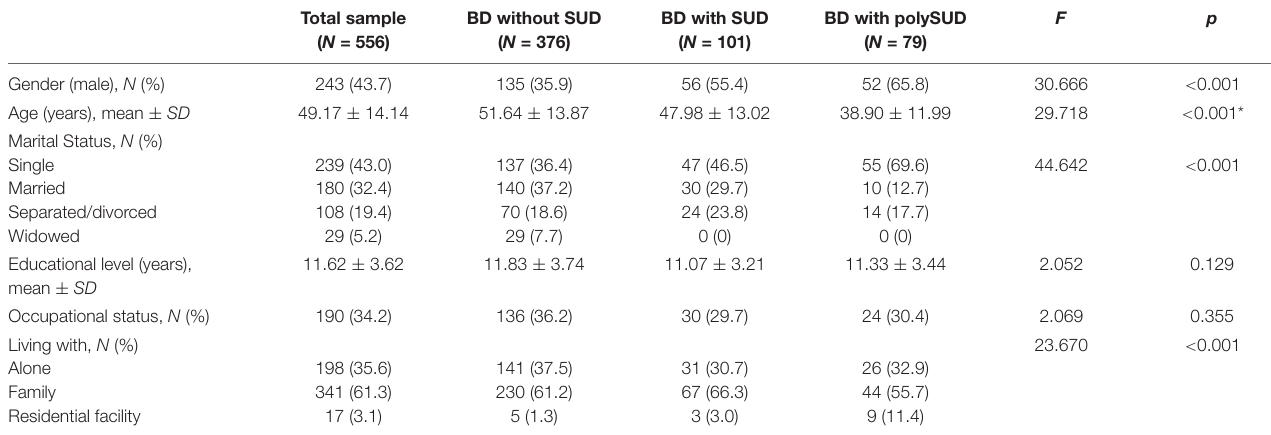
TABLE 1 | Sociodemographic characteristics of the total sample and comparison between the three subgroups.